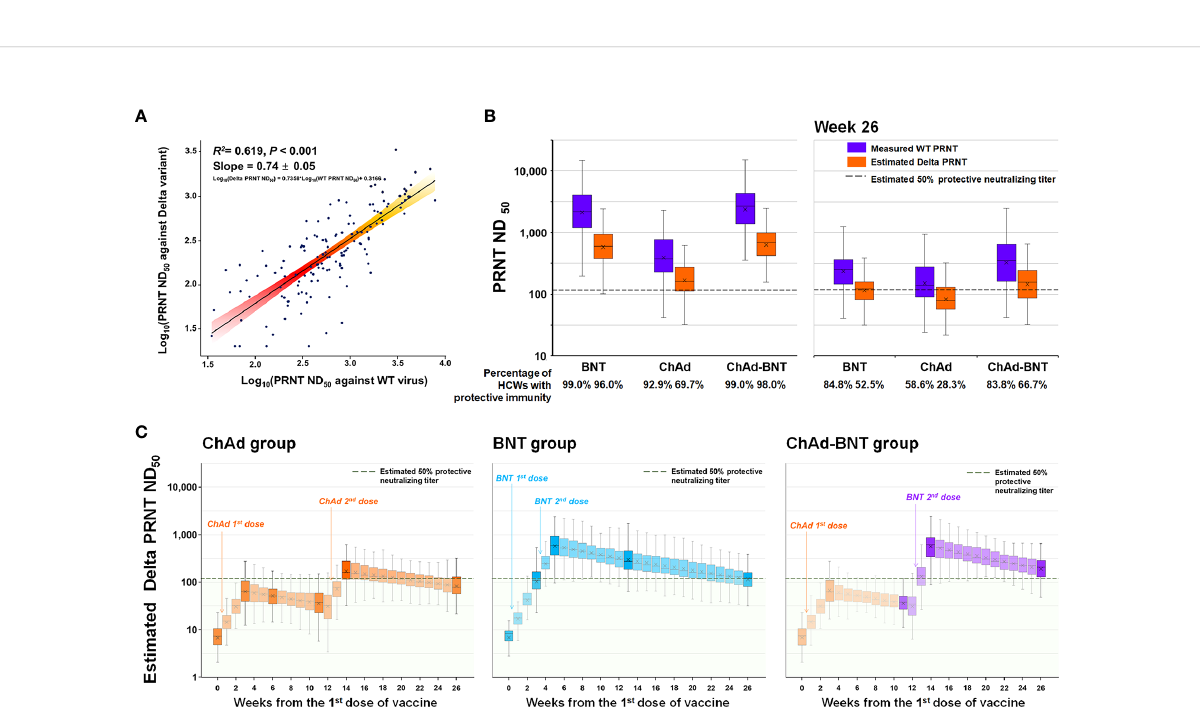
FIGURE 4 Estimated protective immunity against the Delta variant using the PRNT correlation equation. A correlation equation between the PRNT ND 50 against WT SARS-CoV-2 and that against the Delta variant was deduced using 140 serum samples that underwent PRNT against the two strains simultaneously (A) . The PRNT ND 50 against the Delta variant was calculated for each measured time point (B) , and the PRNT ND 50 for each week was estimated using the slope between measured points (C) . WT, wild-type; SARS-CoV-2, severe acute respiratory syndrome coronavirus 2; PRNT, plaque-reduction neutralizing test; ND 50 , 50% neutralizing dose; ChAd, AZD1222 ChAdOx1 vaccine; BNT, BNT162b2 vaccine.